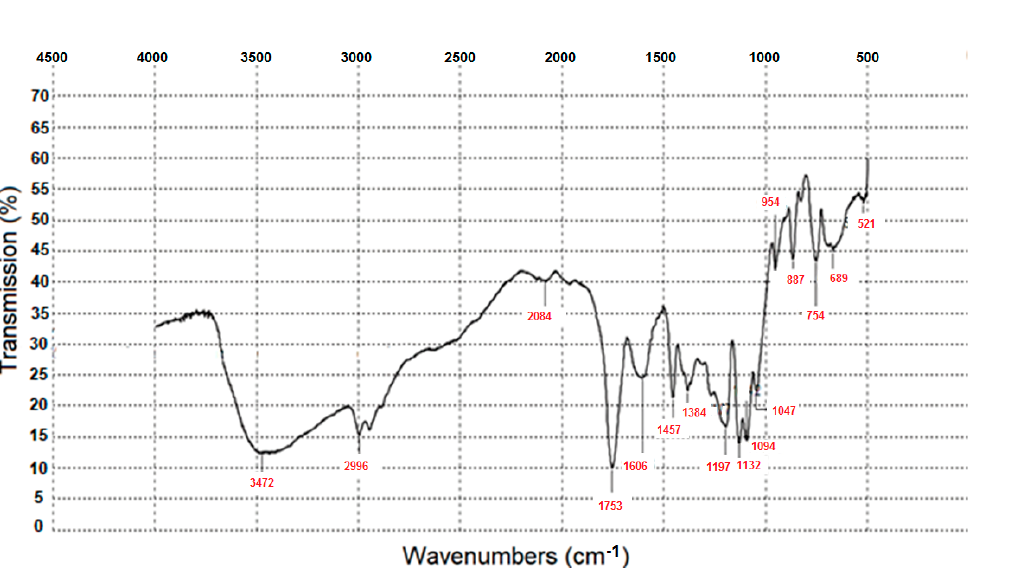
Figure 3. IR spectrum of the obtained polylactide.